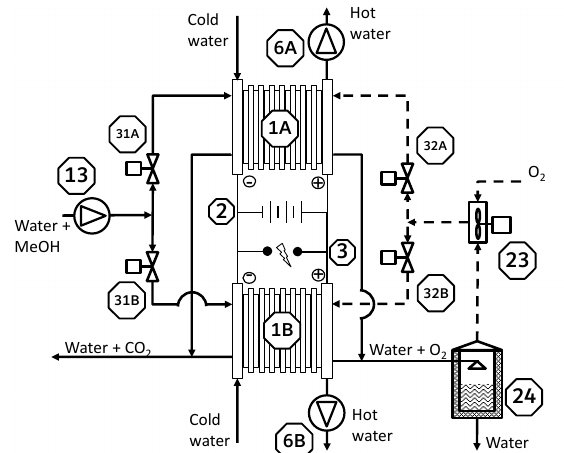
(cid:13) Fuel cell stack A. 1B